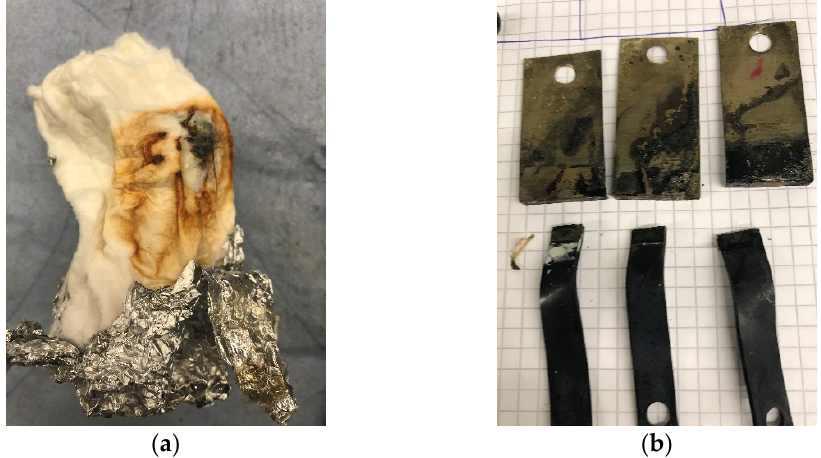
Figure 26. Evaluation of the cataplasm-test: ( a ) opening the vacuum-packed specimen; ( b ) comparison of the 3 specimens.